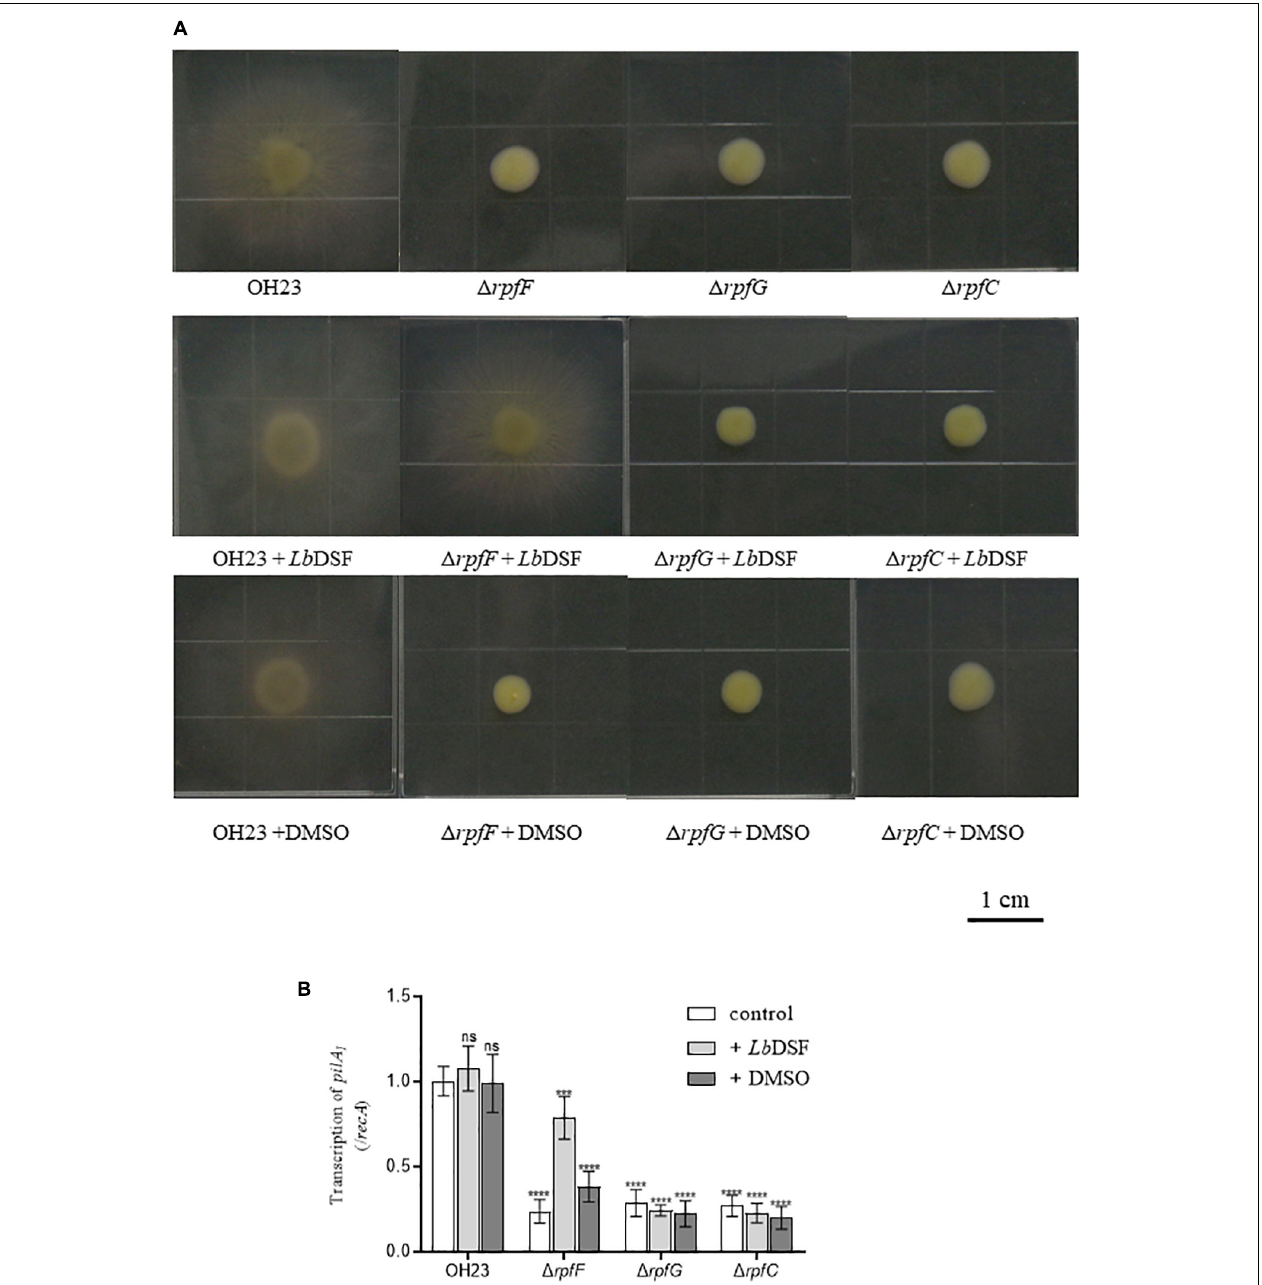
FIGURE 5 | Surface motility of wild-type OH23 and the rpf mutants with or without the exogenous addition of Lb DSF. (A) Surface motility of wild-type OH23 and the rpf mutants with or without the exogenous addition of Lb DSF. Each strain was grown in liquid NB medium until the culture reached an OD 600 of approximately 1.0. Then, 3 µ l of strain was inoculated onto the surface of NB plates. The plates were inoculated at 28 ◦ C for 4 days. For the Lb DSF treatment group, the strains were grown in NYG liquid medium containing 2 µ M Lb DSF. (B) pilA 1 expression in wild-type OH23 and the rpf mutants with or without the exogenous addition of Lb DSF. Different numbers of star ( ∗ ) above the bars indicate a significant difference between the wild-type strain OH23 and mutant strains (ns: not sigificant, ∗∗∗ P < 0.001; ∗∗∗∗ P < 0.001, t